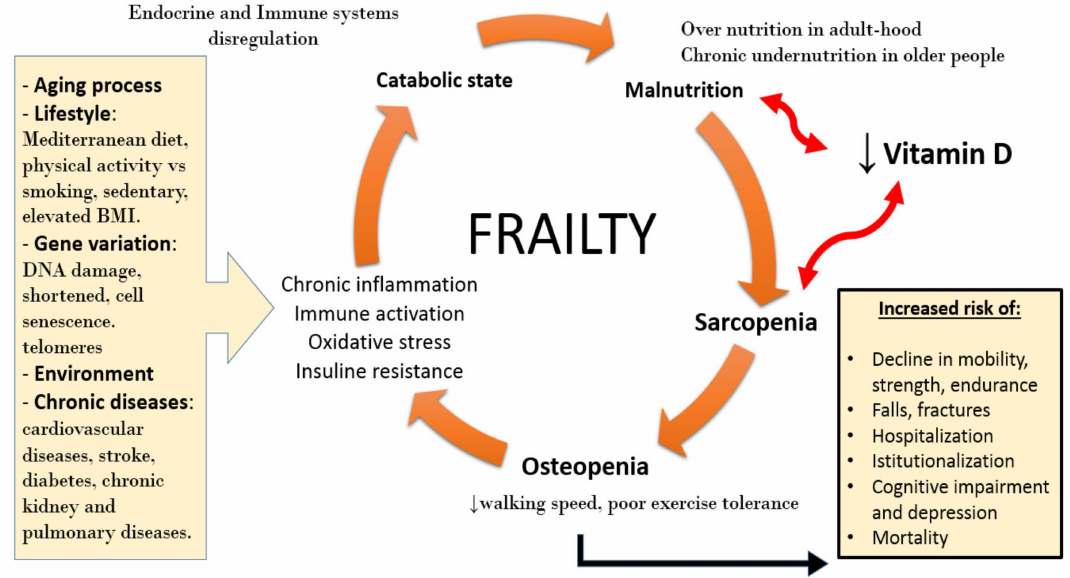
Figure 3. Putative role of vitamin D in sarcopenia and